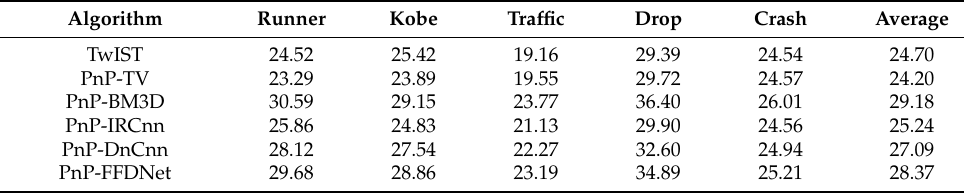
Table 1. The average PSNR (dB) results.